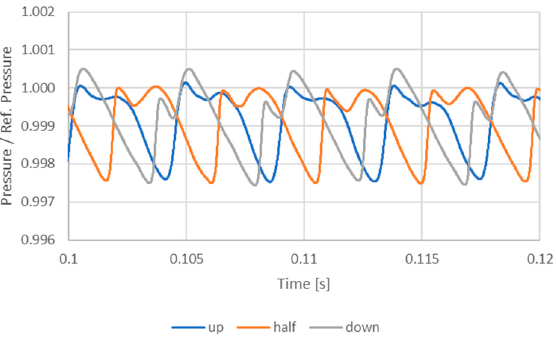
Figure 5. Pressure evolution in di ff erent pipe sections with the damper inactive, pump speed = 1500 rpm.